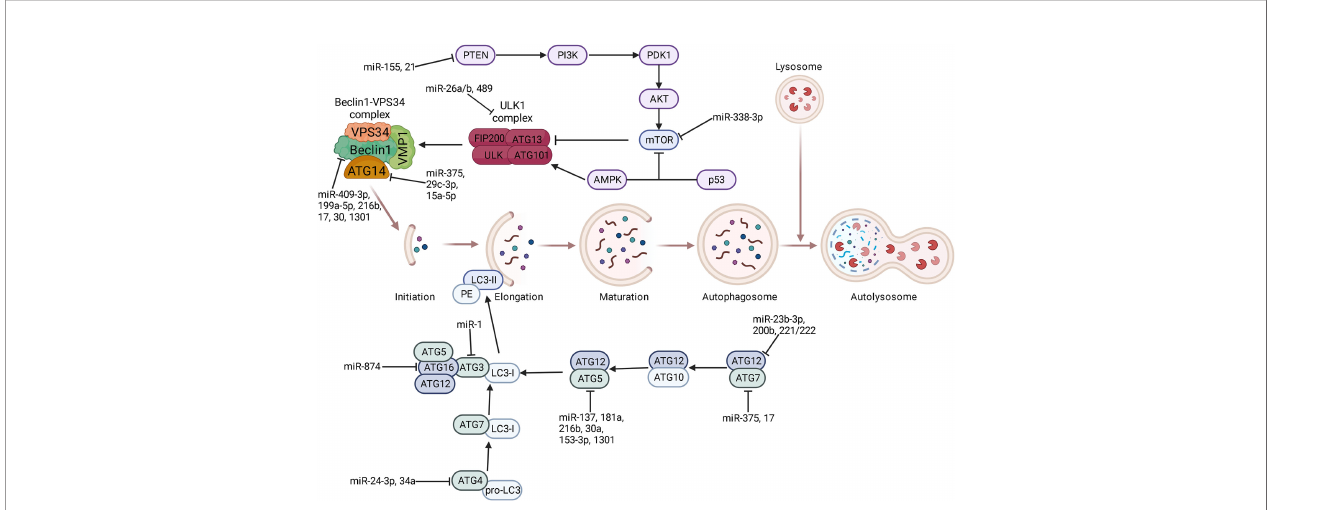
FIGURE 1 | The regulatory role of miRNAs on each stage of autophagy. Core proteins and signaling pathways are related to each stage of autophagy including phagophore initiation and elongation, autophagosome maturation, and lysosomal fusion. Some key miRNAs target autophagy-related genes at the post-transcriptional level to participate in every stage of autophagy. ⊥ indicates an inhibitory effect and ! indicates a promoting